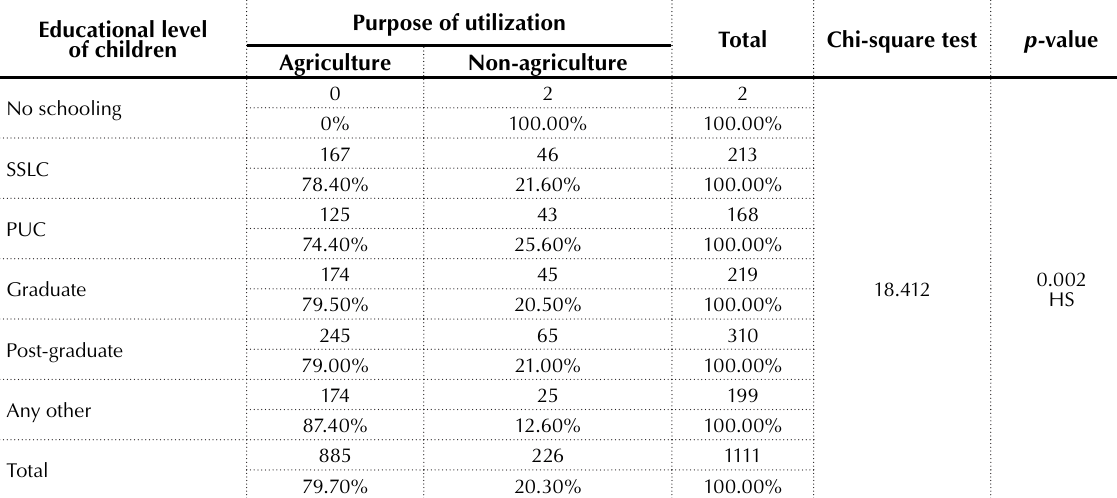
Source: Primary data.